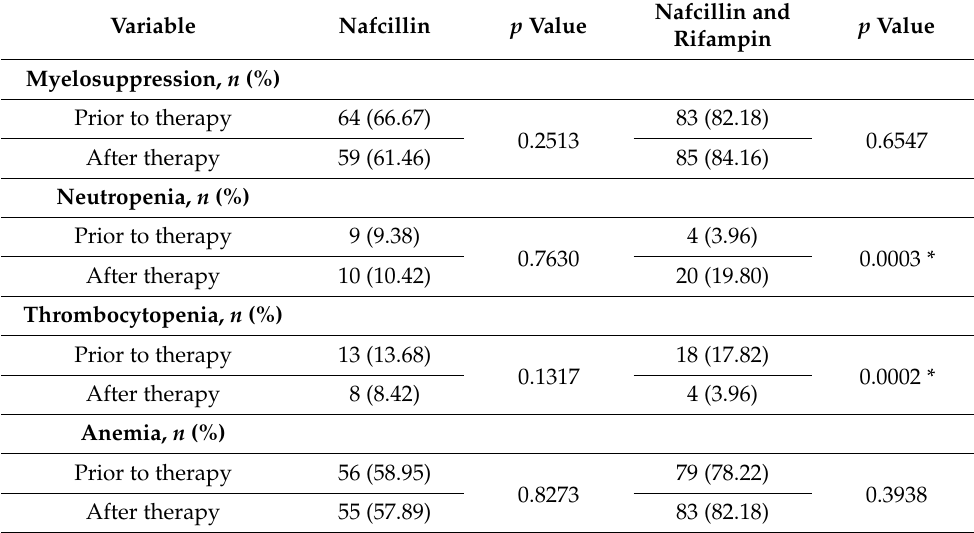
Table 2. Primary and secondary